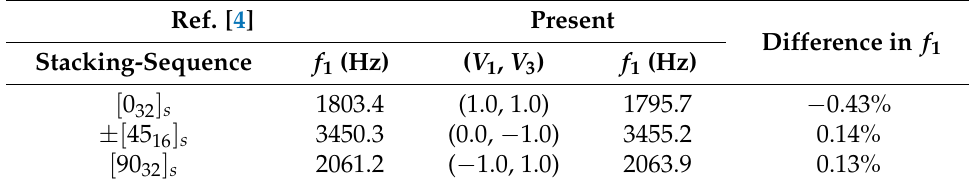
Table 3. Comparison of the fundamental frequencies obtained in the present study and ref. [4]. Ref.